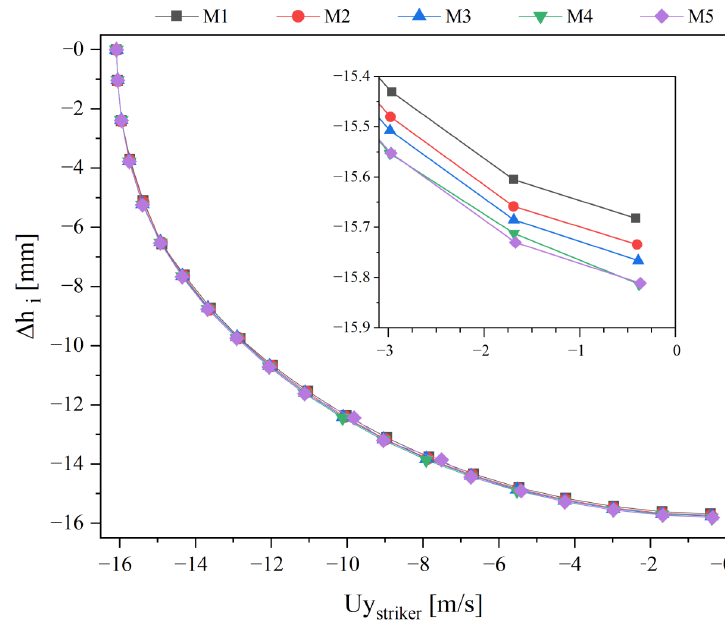
Figure 12. Inner toe cap y variation vs. striker velocity, for impact